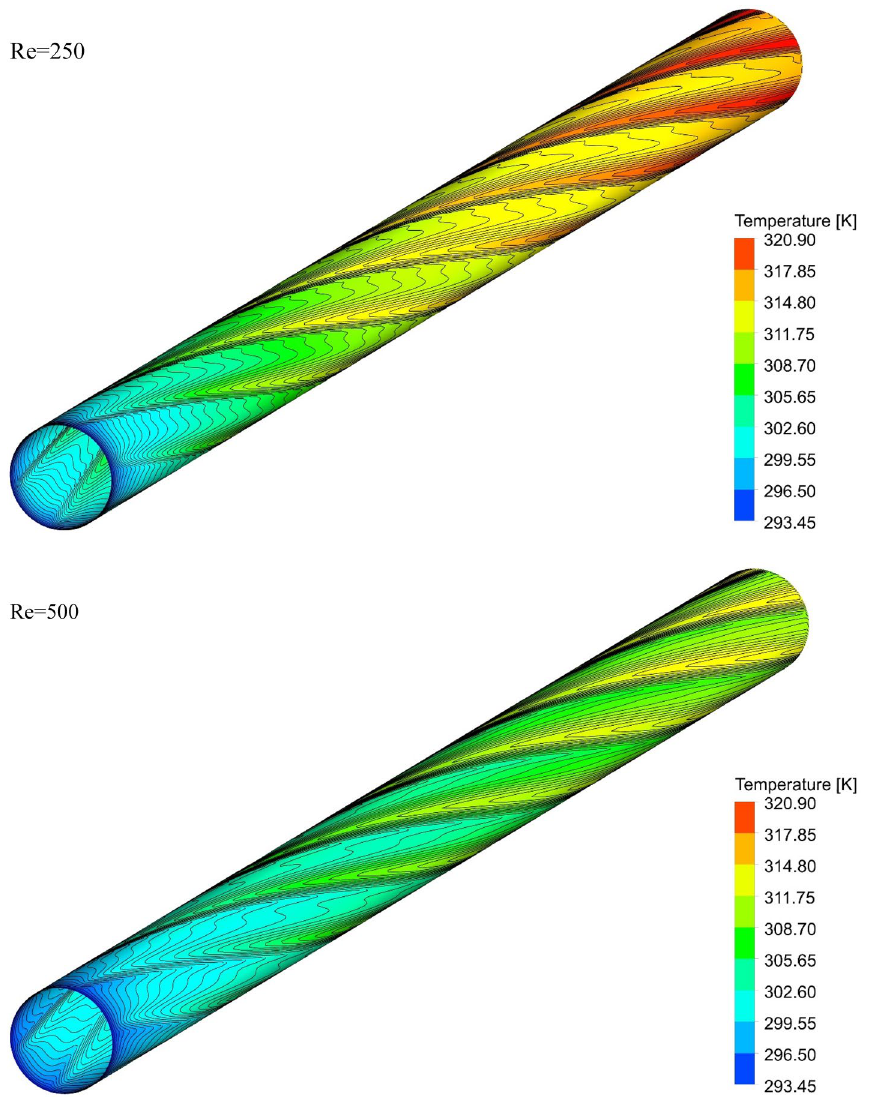
Figure 16. Isotherm contours on the surface of the pipe in φ = 0% and Case